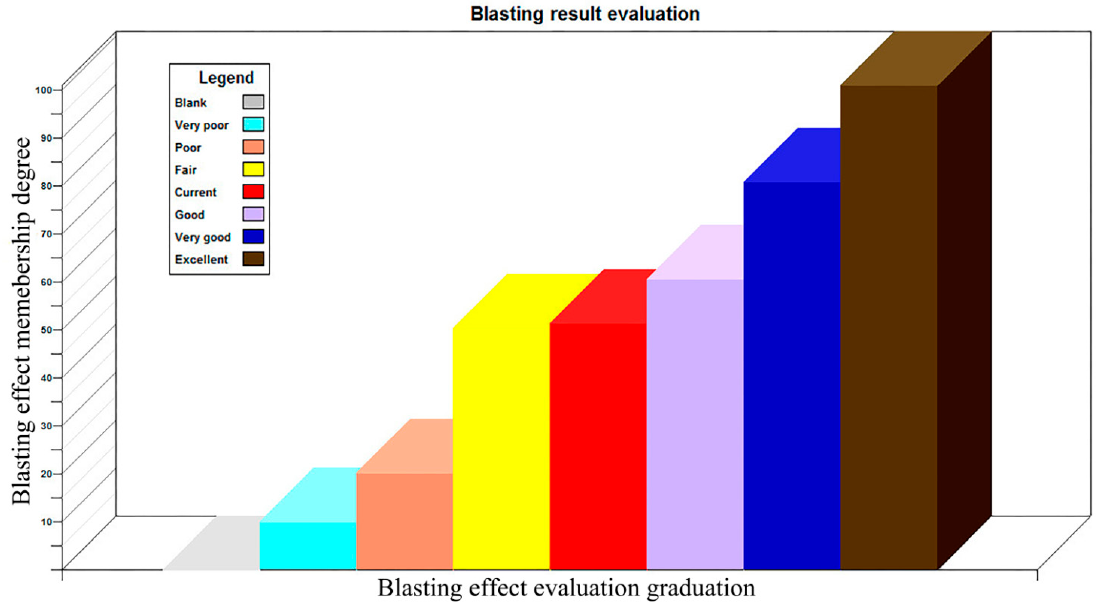
Figure 8. Histogram of blast comprehensive evaluation. Figure 7. Histogram of blast comprehensive